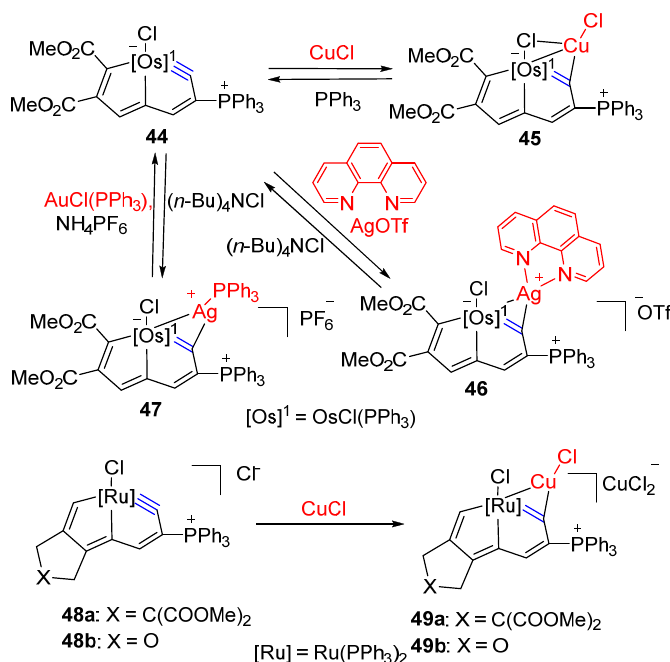
Scheme 10. Reactions of metallapentalynes with coinage metal